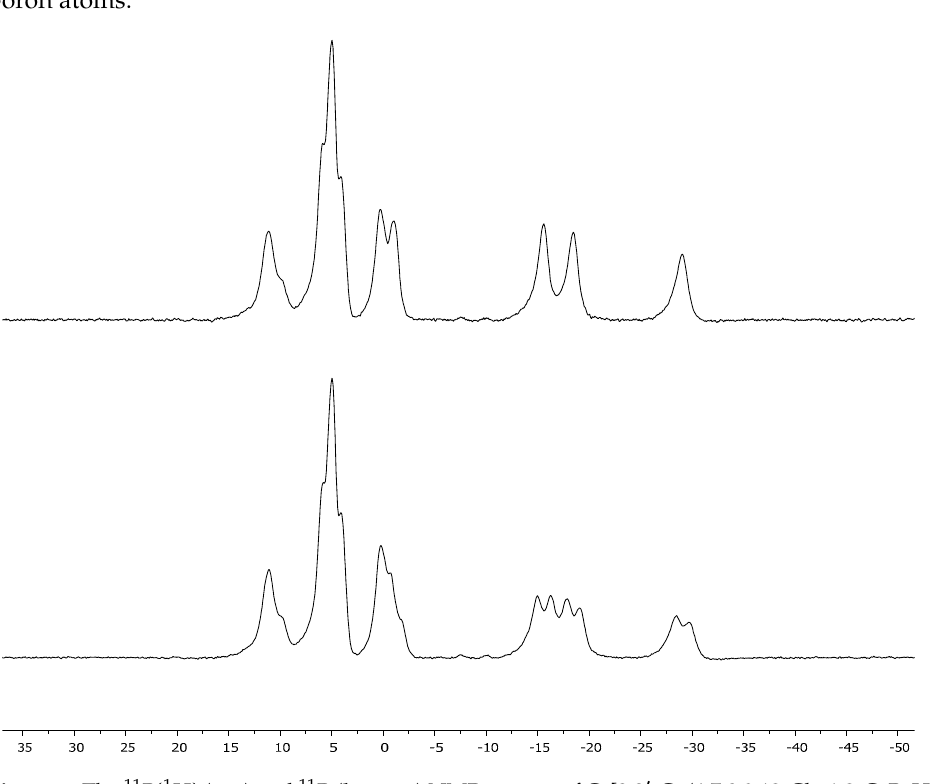
Figure 1. The 11 B{ 1 H} ( top ) and 11 B ( bottom ) NMR spectra of Cs[3,3 (cid:48) -Co(4,7,8,9,12-Cl 5 -1,2-C 2 B 9 H 6 ) 2